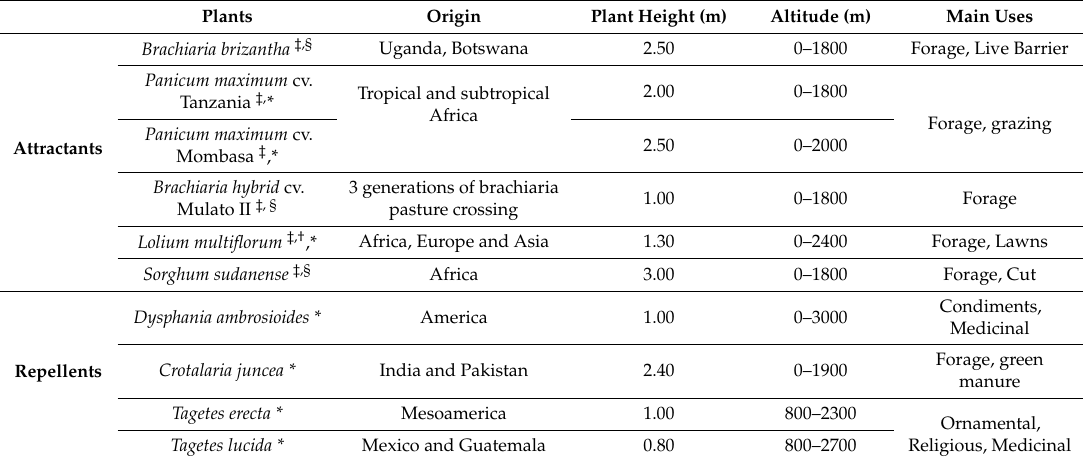
Table 1. Characteristics of potential attractant or repellent plants, tested for the design of push–pull strategies to manage S. frugiperda at Yautepec, Morelos,